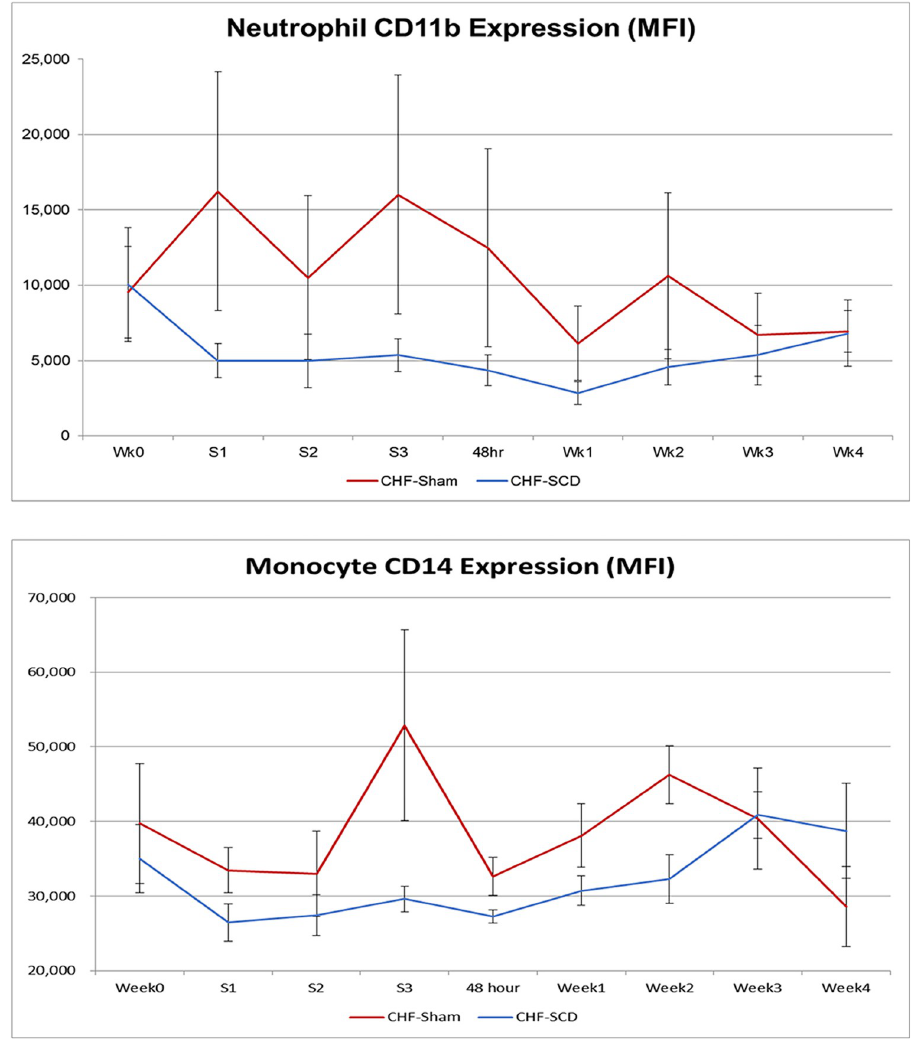
Fig 4. SCD treatments diminishes activation markers in circulating leukocytes compared to sham controls. SCD treatment lowered the MFIs of the cell surface markers CD11b for circulating neutrophils and CD14 for circulating monocytes compared to sham treatment at various time points during the 4 week evaluation